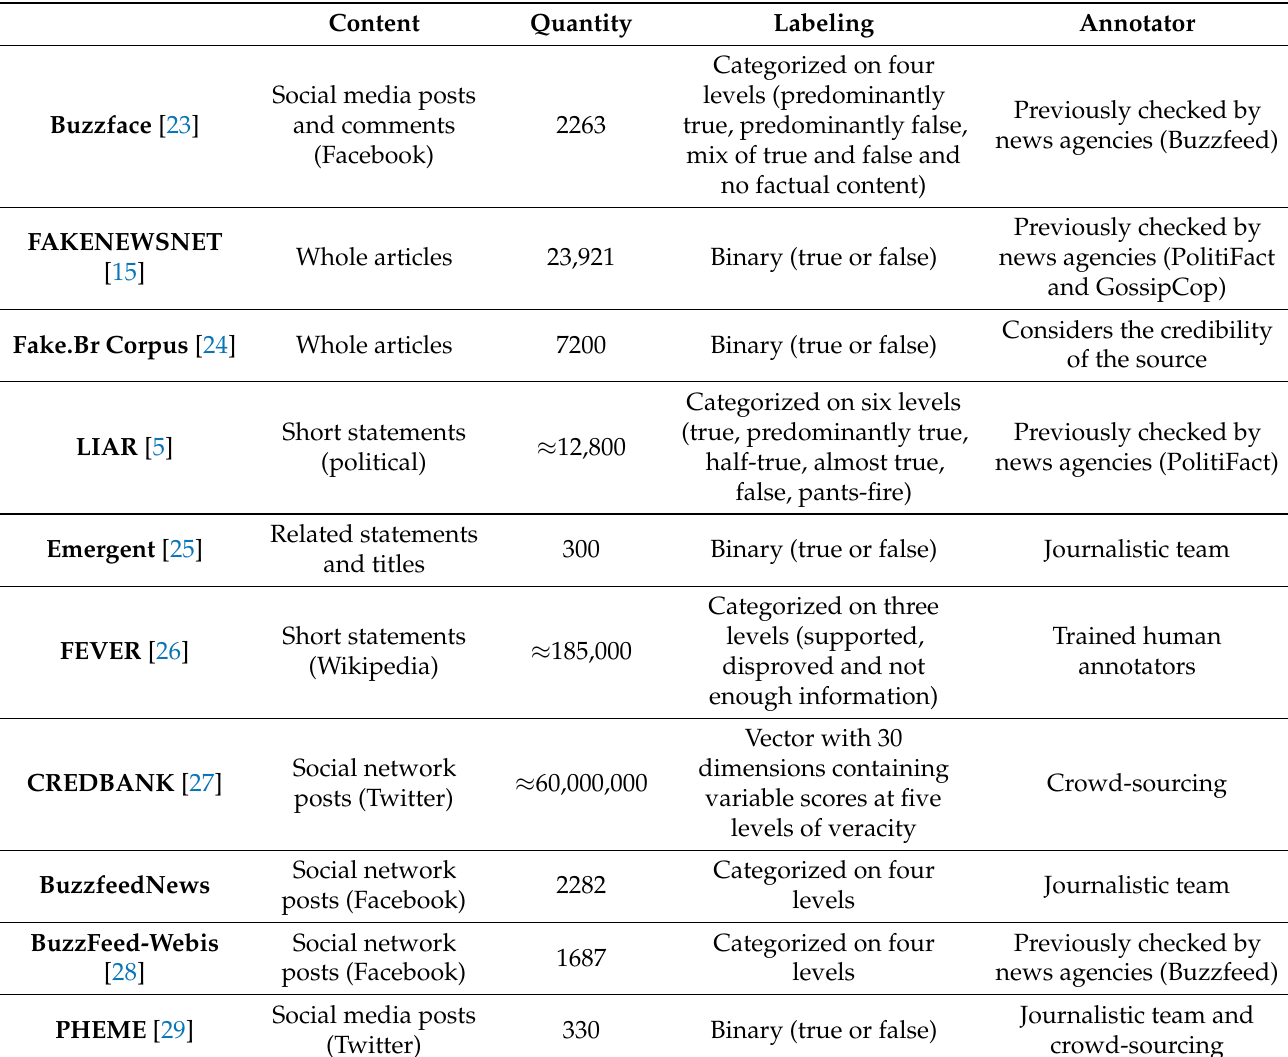
Table 2. Fake news datasets